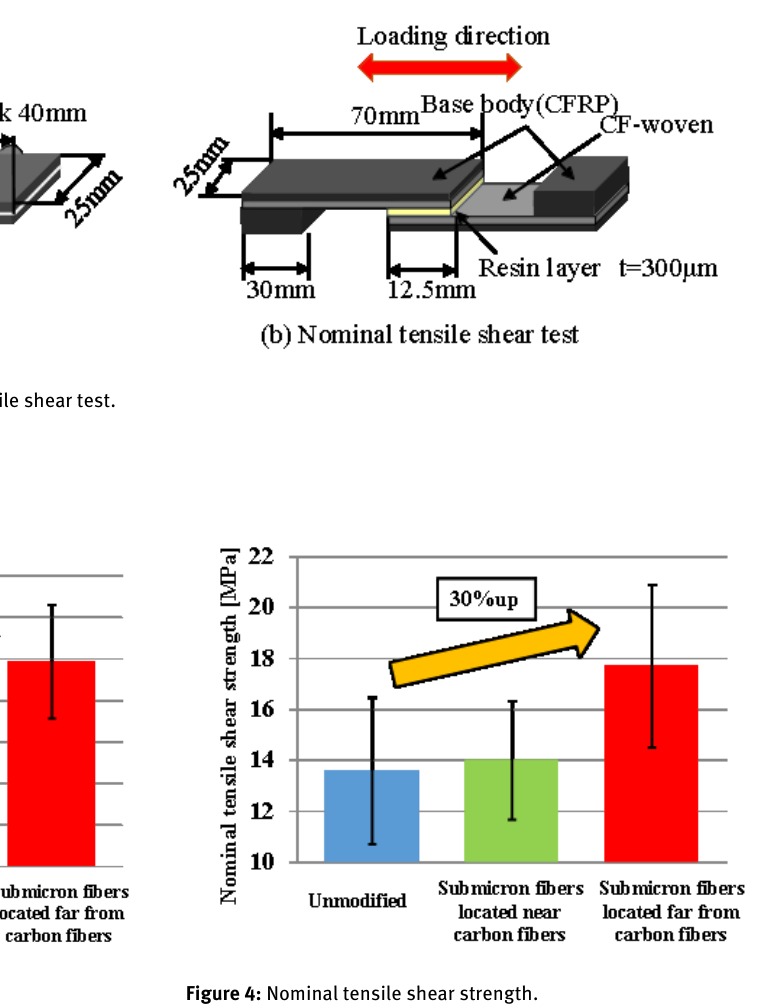
Figure 3: Mode-2 fracture toughness. Figure 4: Nominal tensile shear